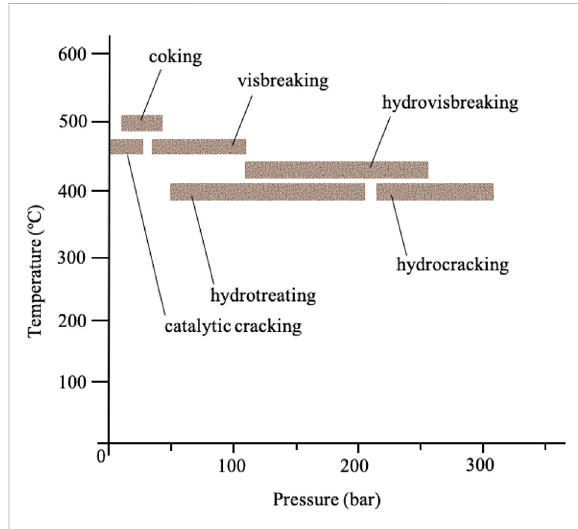
FIGURE 2 Hydroprocessing examples based on the process conditions (temperature and pressure) (Bose,